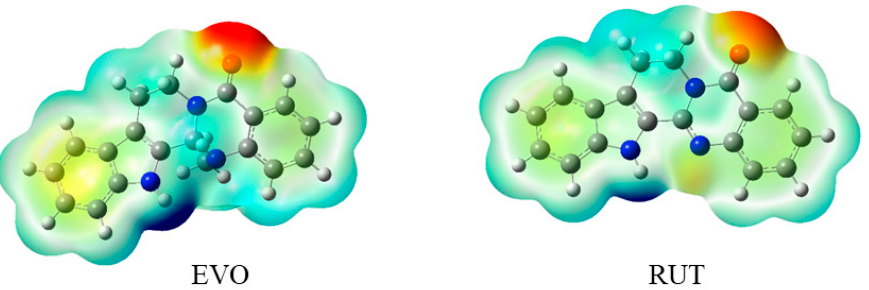
Figure 2. Molecular electrostatic potential map of evodiamine (EVO) and rutaecarpine (RUT). The molecular electrostatic potential is mapped on the iso-surface of electron density with an iso-value of 0.001. The MEP color ranges from − 0.06 (red) to 0.06 (blue). The unit is au.